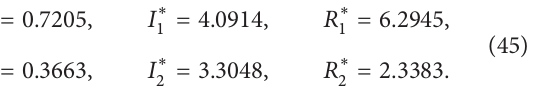
Figure 2 corresponds to 𝜎 11 = 0.4 , 𝜎 21 = 0.73 , 𝜎 31 = 0.45 , = 0.5 , 𝜎 = 0.67 , and 𝜎 = 0.5 ; the numerical 𝜎 12 22 32